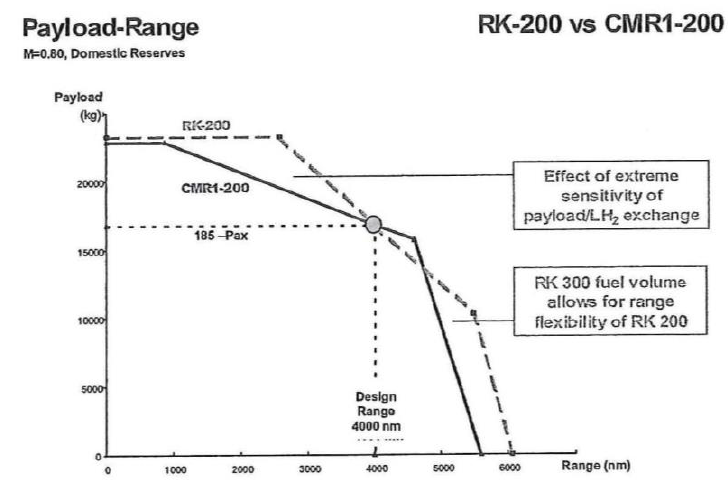
Figure 20. Comparison of the payload range diagram for a reference kerosene aircraft and a cryogenic medium-range aircraft designed in the Cryoplane project [35]. (RK: reference kerosene; CMR1-200: Cryogenic Medium Range aircraft).